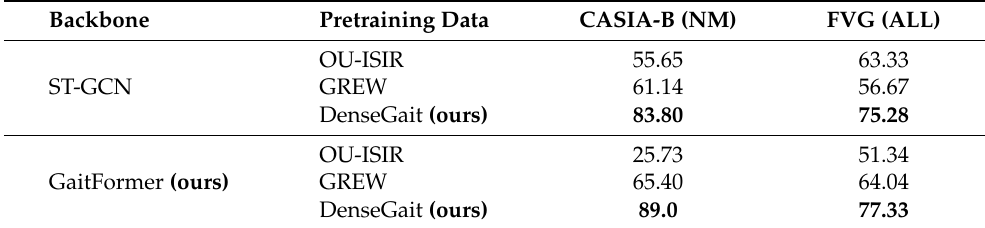
Table 5. Comparison between GaitFormer and ST-GCN pretrained with Supervised Contrastive on GREW [12], OU-ISIR [13] and our proposed DenseGait. Performance is directly correlated with mean tracklet duration on each dataset as shown in Figure 1. We highlight in bold the best results for each architecture and dataset.